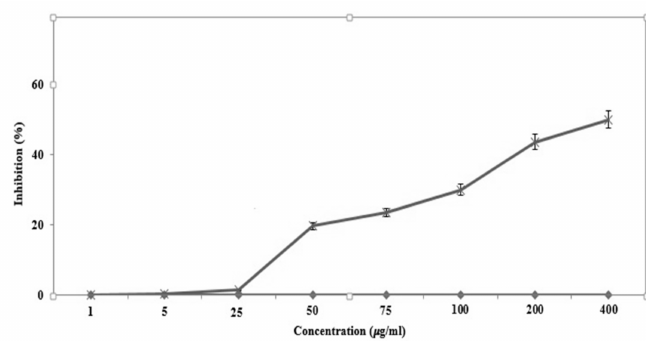
Figure 5. The parasitological effects of IONPs on Leishmania major